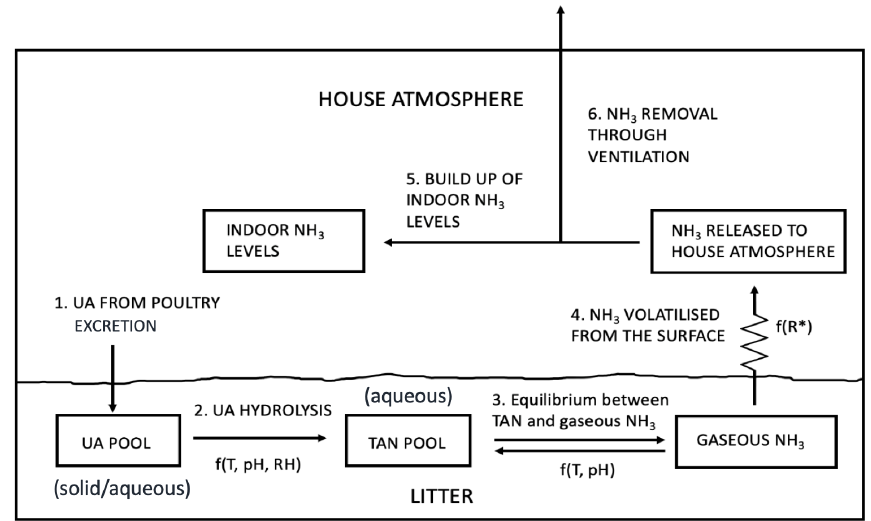
Figure 2. Schematic of NH 3 volatilization in the poultry house. UA is uric acid; TAN is total ammoniacal nitrogen; R ∗ is the resistance for gaseous transfer from the litter surface to the in-house atmosphere (adapted from Elliott and Collins,